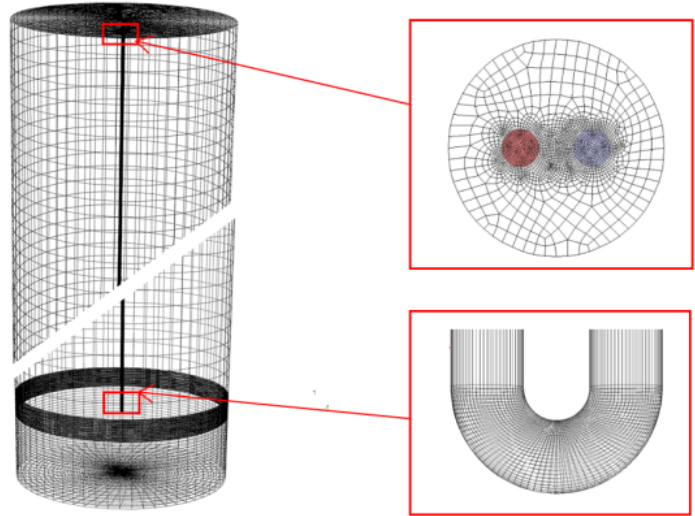
Figure 1. Geometry and its mesh for the numerical simulations.